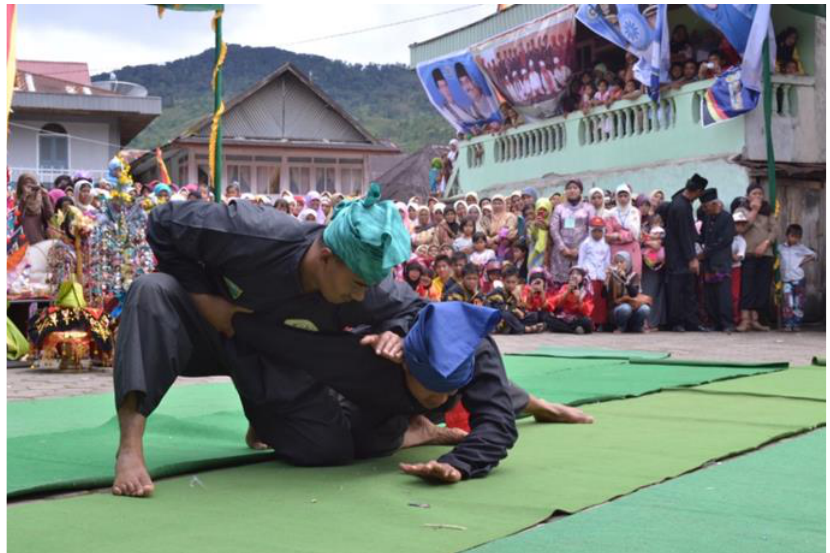
Fig. 3 Silek Performance in Nagari Talang Babungo, (Muliati,